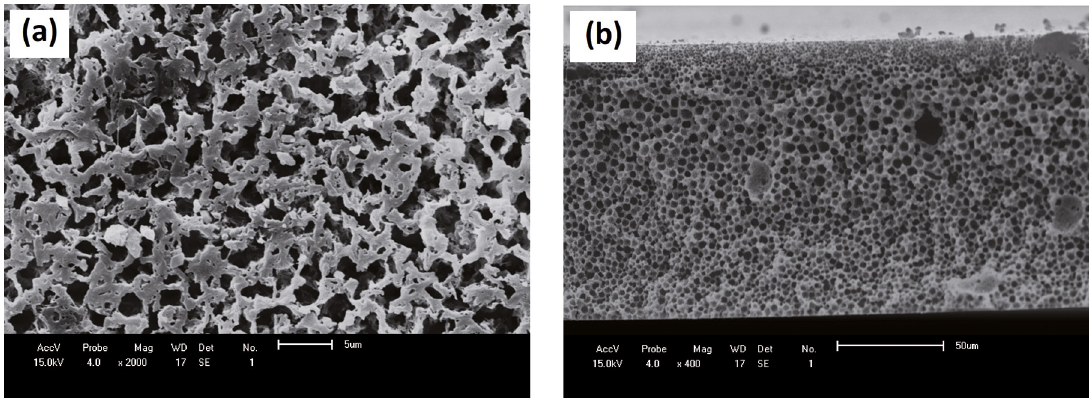
membrane: (a) top surface and (b) cross-section. 2